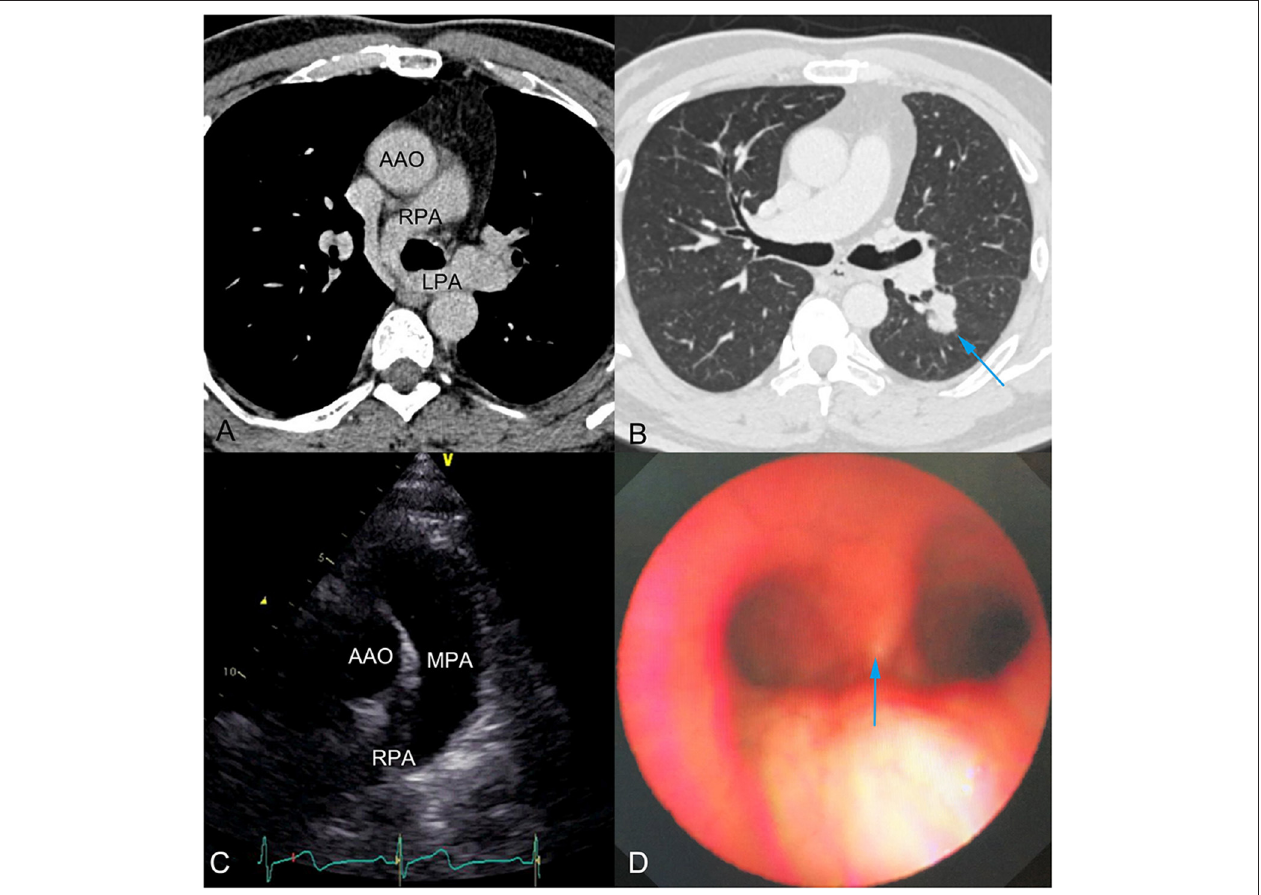
FIGURE 1 | (A) Chest computed tomography (CT) showed pulmonary artery sling, which was observed for the first time during his life. (B) Preoperative chest CT showed a nodule of 2.5cm diameter and indicated the possibility of malignancy (blue arrow). (C) Transthoracic echocardiography showed the main pulmonary artery had only one outflow tract to the right pulmonary artery. The beginning of the left pulmonary artery could not be detected, due to its deep position. (D) Bronchoscopy showed no obvious tracheal stenosis or bronchomalacia. Blue arrow indicates the tracheal carina. AAO, Ascending aorta; RPA, Right pulmonary artery; LPA, Left pulmonary artery; MPA, Main pulmonary